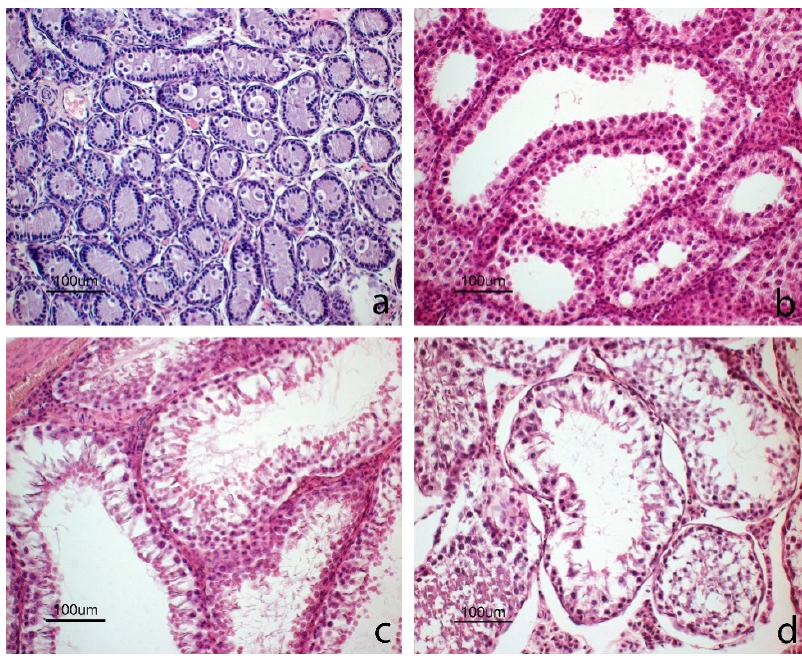
Figure 4. Images of testicles in different reproductive phases. ( a ) Immature phase: germinal epithelium where tubules are small and devoid of lumen; the epithelium consists of numerous Sertoli cells located at the base and some spermatogonia with abundant cytoplasm in a more central position. ( b ) Pubertal phase: some tubules have large lumen and the epithelium consists mainly of basal Sertoli cells and primary spermatocytes in the luminal compartment; round spermatids and a cluster of Leydig cells can also be observed. ( c ) Spermatogenesis phase: all tubules show a large lumen; epithelium is completely formed and is in active spermatogenesis with elongated spermatids. ( d ) Regression phase: testicles with degenerated germinal cells occupying the